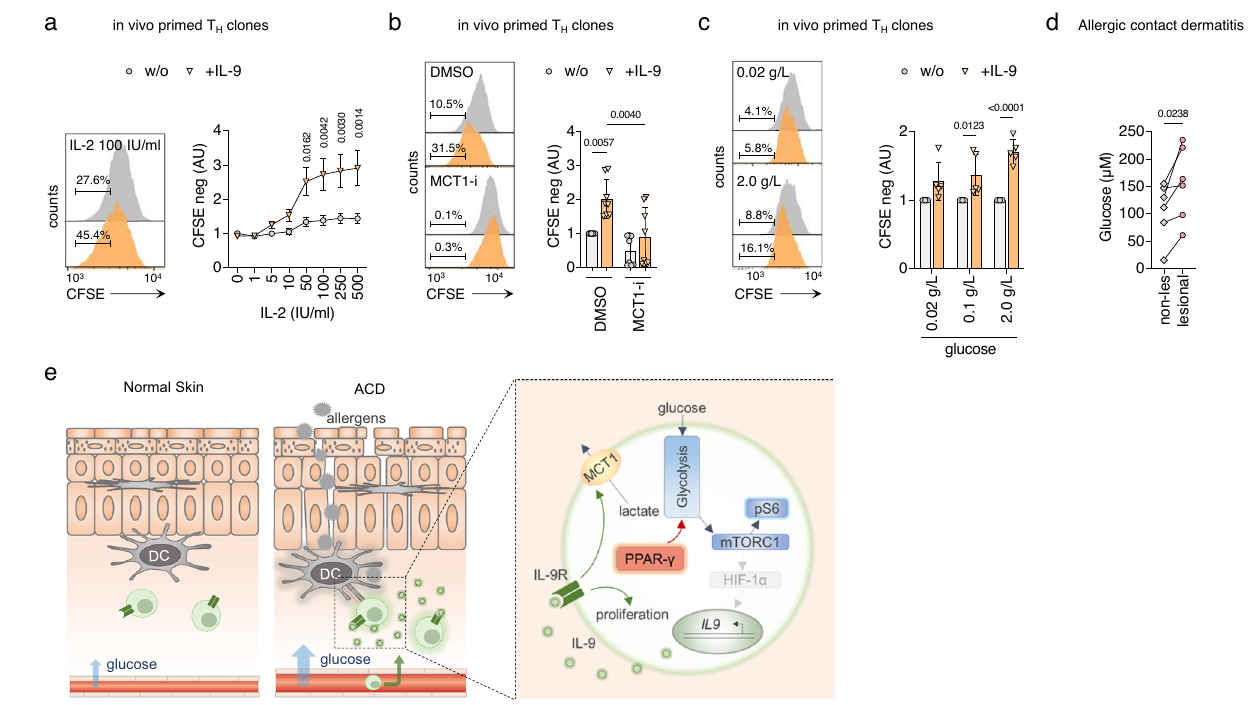
Fig. 6 | IL-9 promotes T-cell proliferation in the high-glucose environment of allergic contact dermatitis. a Proliferation of in vivo primed IL-9R + T H clones in presence of IL-9 and different concentrations of IL-2, measured with CFSE dilution by fl ow cytometryafter 3days. b Proliferation of in vivo primedIL-9R + T H clones in presenceof IL-9 and MCT1inhibitor (MCT1-i)BAY-8002 measured asin a . c In vivo primed IL-9R + T H clones were cultured in media containing glucose of different levels for 7 days. Proliferation was measured in the presence of IL-9 with CFSE dilution by fl ow cytometry as in a . d Glucose concentrations measured with the Glucose-Glo TM Assay(Promega)ofinterstitial fl uidsoflesionalskinofpositivepatch